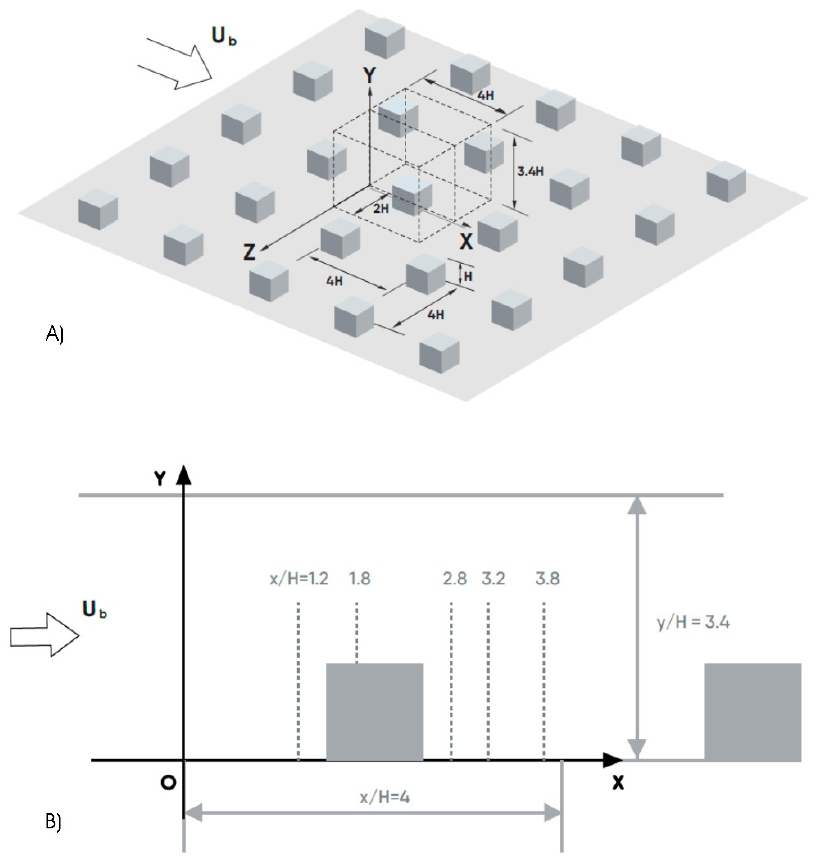
Figure 1. ( A ) Schematic of the 3D computational domain for the flow past an array of cubes, ( B ) 2-D view of an XY plane with locations at which comparisons between numerical and experimental results were performed.